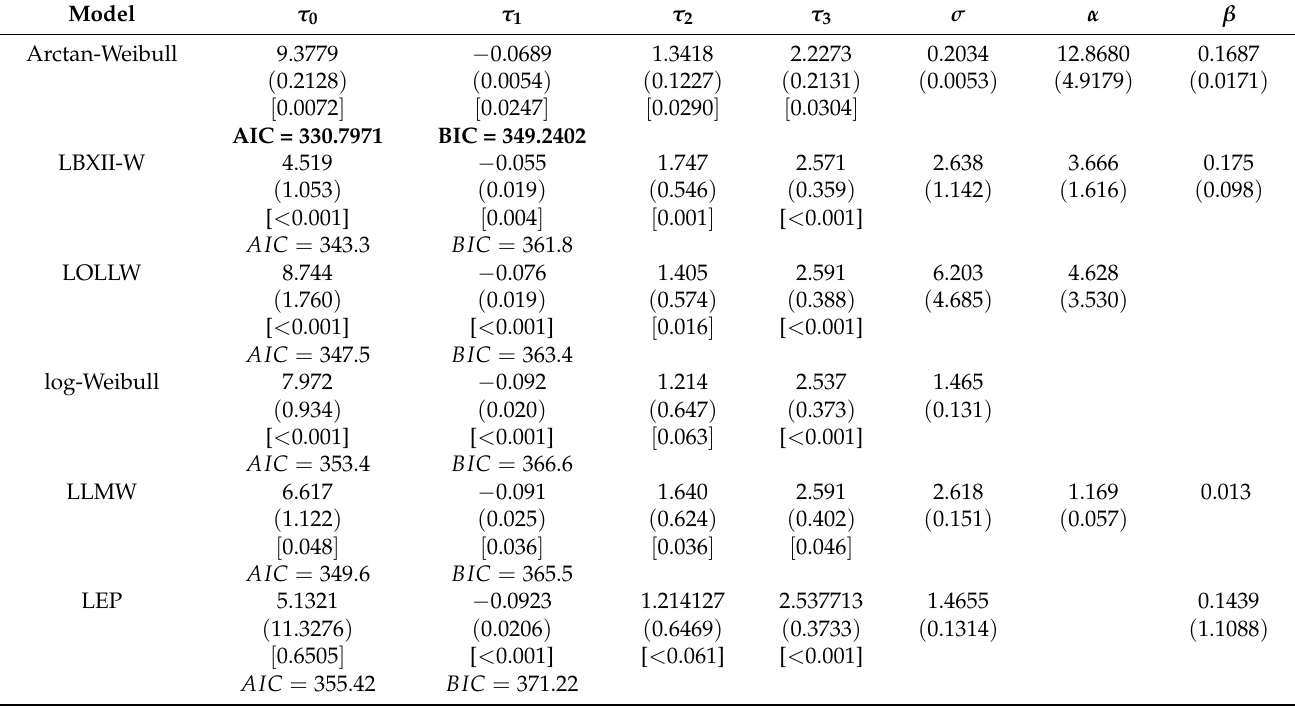
Table 4. A summary of fitted regression models to the heart transplant data.